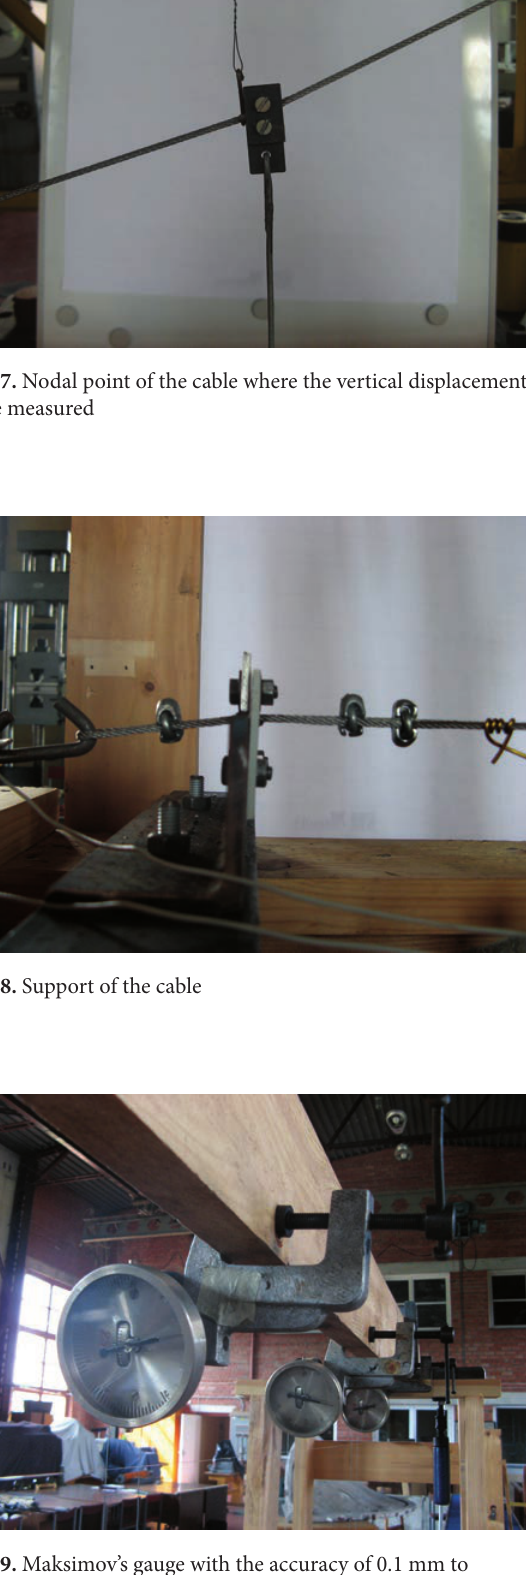
Fig. 9. Maksimov’s gauge with the accuracy of 0.1 mm to measure the vertical displacements of the nodal points